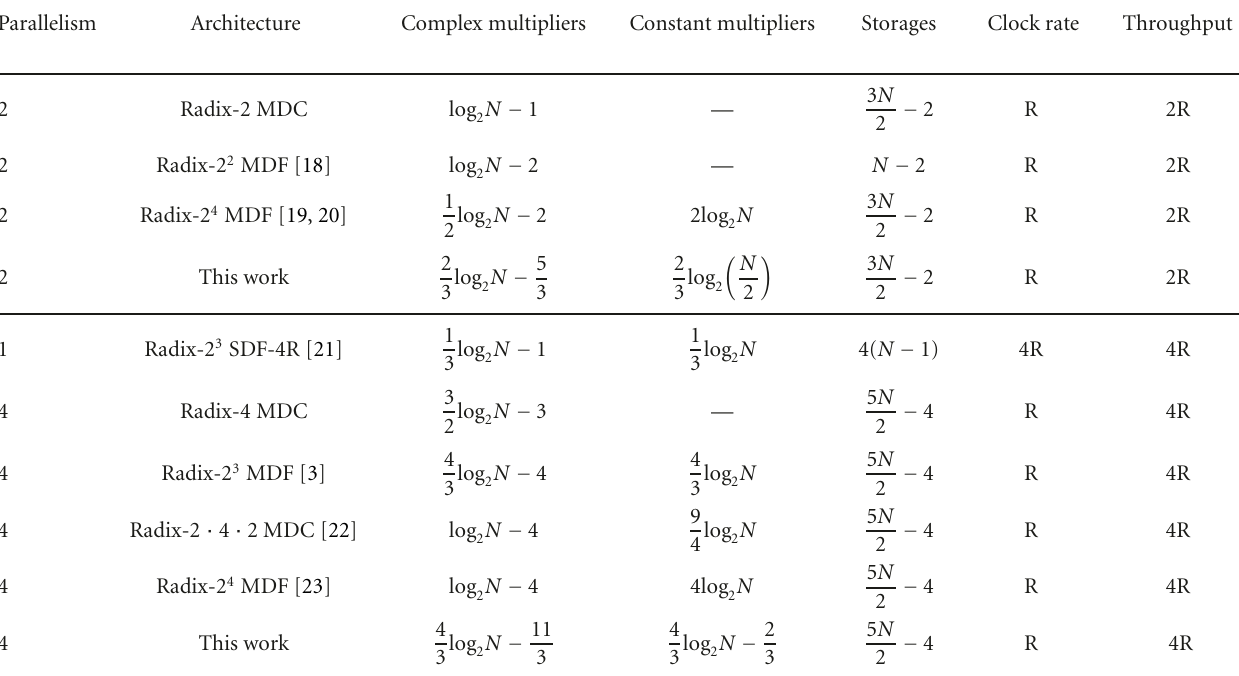
Table 2: Complexity comparison of several FFT processors with